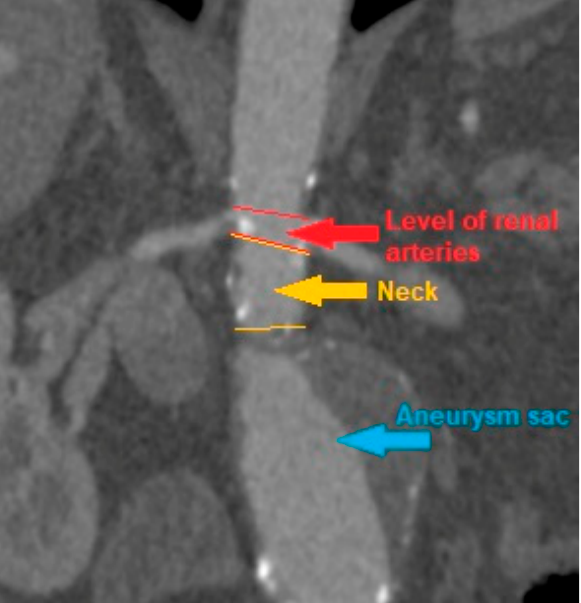
Figure 1. An example of computed tomography of patient with infrarenal abdominal aortic aneurysm with present neck segment.